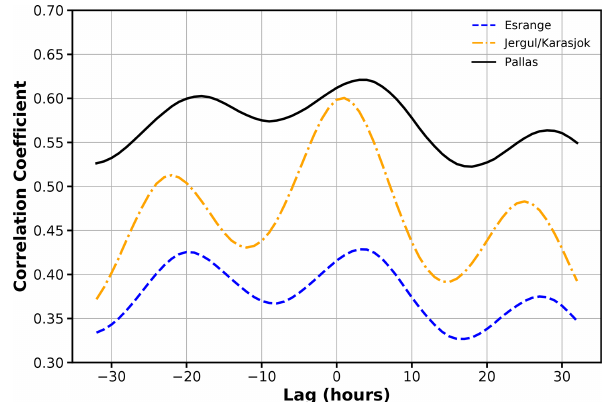
Figure 5. Temporal correlation of [ O 3 ] data between Svanvik and other ozone monitoring sites in northern Fennoscandia over time lag. The time-lag correlation has been computed by shifting one of the series by (cid:49)t . A negative lag means that Svanvik lags behind, while a positive lag mean the other station lags behind. The high- est correlation with Pallas/Esrange is found at a time lag of 3h for Jergul/Karasjok at